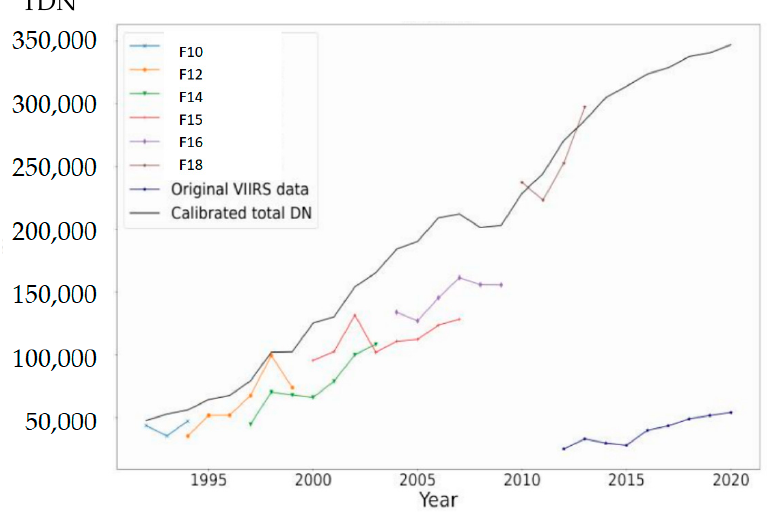
Figure 7. Comparison between the calibrated total DN and the original total DN.